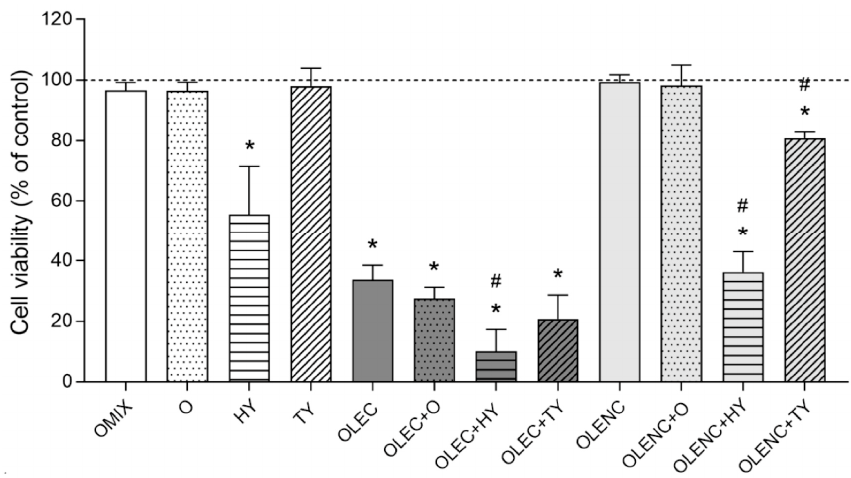
Figure 3. Antiproliferative activity of olive leaves extract (OLE). HL-60 cells were challenged with fresh (OLEC) and purified (OLENC) extracts in the absence or presence of pure oleuropein (O), hydroxytyrosol (HY), or tyrosol (TY) for 24 h at the concentrations indicated in Table 2 of the Experimental Design. Cells were also treated with OLE’s major individual phenolic compounds and the mixture of them (OMIX) at the same conditions. The dashed line represents control (untreated) samples. Results are shown as means ± SD of six independent experiments run in triplicate. * p < 0.05 vs. untreated samples (100% of cell viability; Tukey’s multiple test). # p < 0.05 between doped extracts and their corresponding non-doped extract (Tukey’s multiple test).